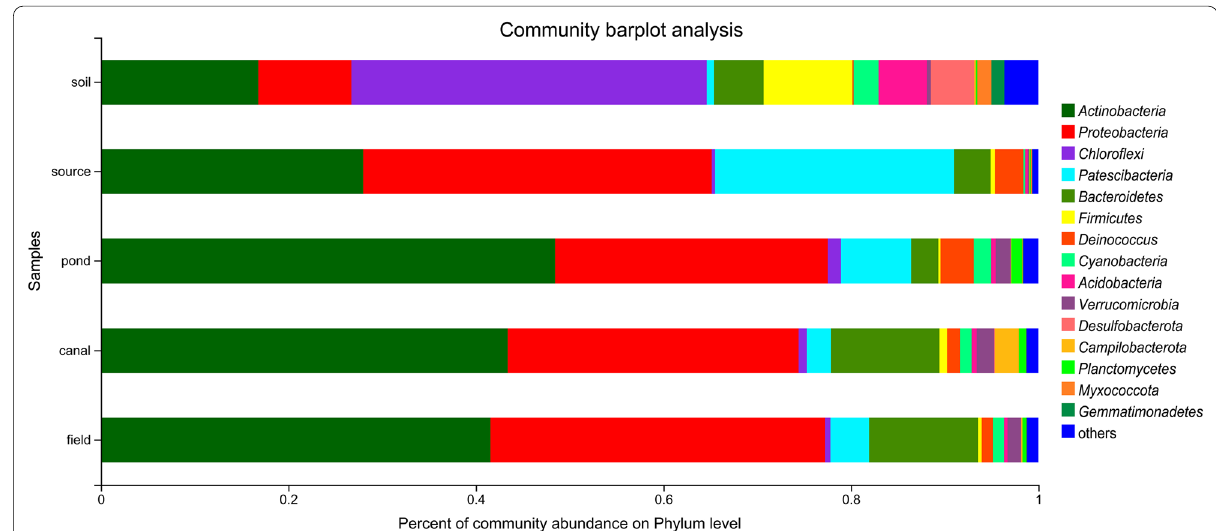
Fig. 5 Bacterial community structure of five environmental sample groups at the phylum level. Soil, soil bacteria samples from six areas in rice fields; source, pond, and field, planktonic bacteria samples collected from the water inlet for the experimental area, from three aquaculture ponds, and from three areas in rice fields; canal, planktonic bacteria samples collected from the canal system between aquaculture and rice fields. A higher relative abundance of Firmicutes was found in the soil bacteria samples than in the water